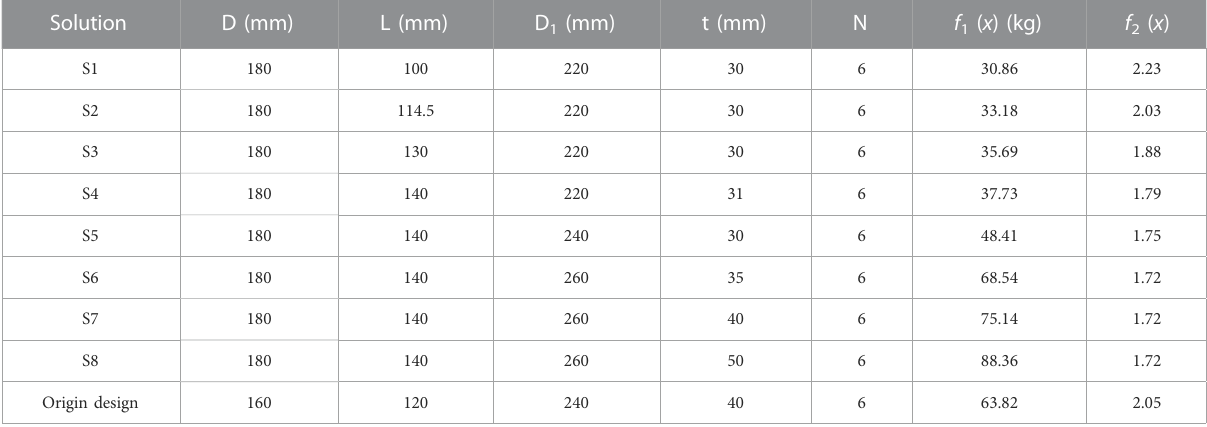
TABLE 1 The obtained optimized